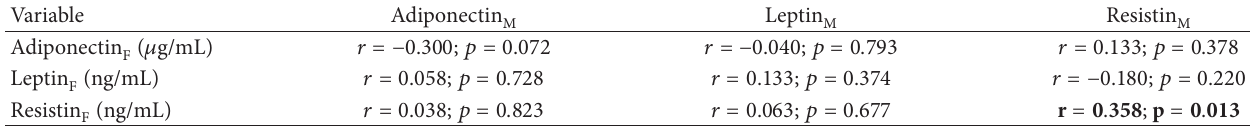
Table 4: Spearman’s correlation coefficients between maternal and fetal